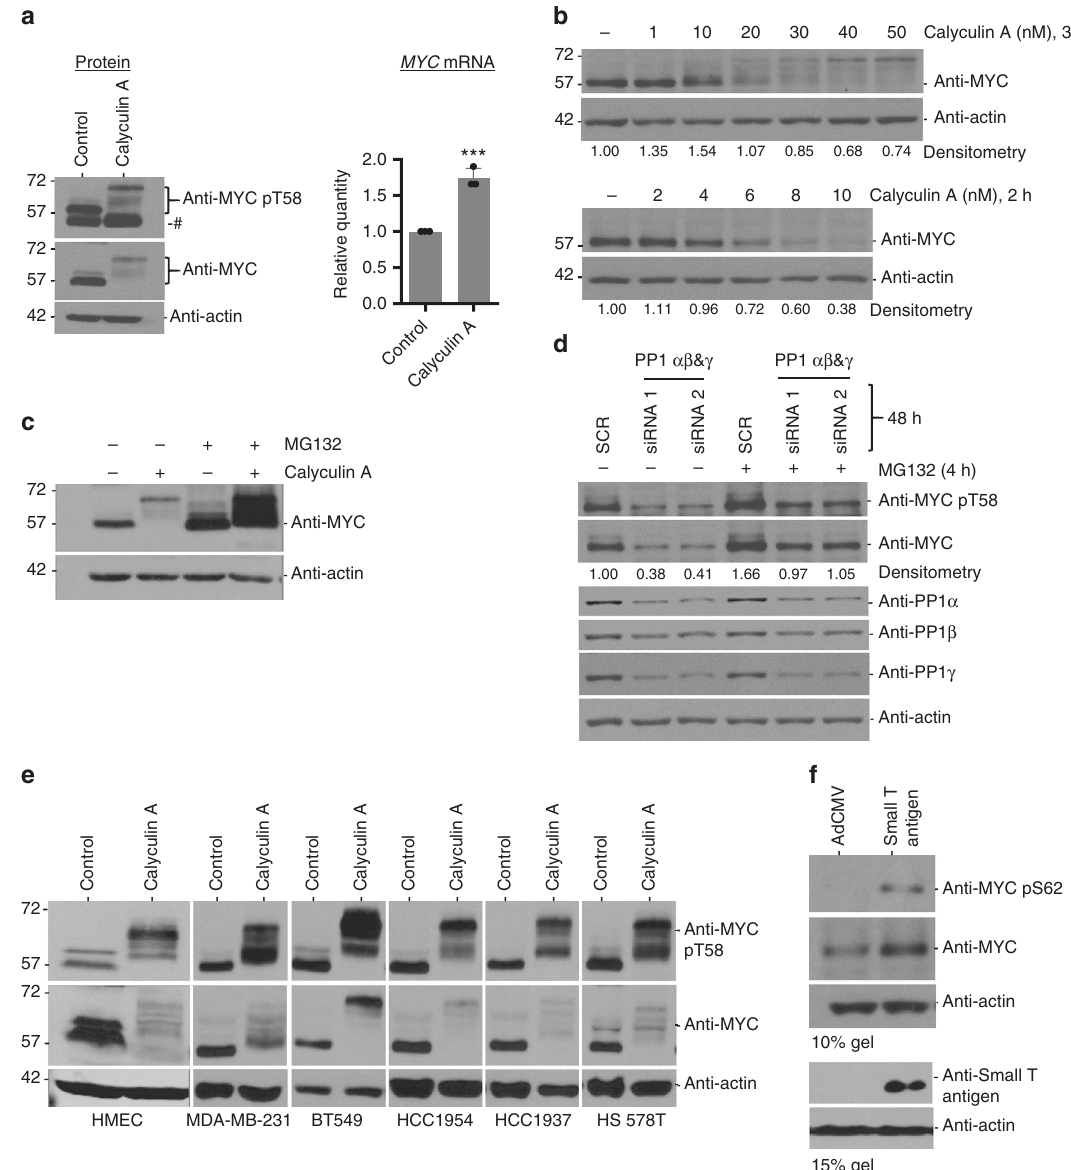
Fig. 3 Inhibition of PP1 results in decreased MYC protein levels. a MCF10A cells treated with Calyculin A (50 nM) for 30 min and lysed for protein or RNA extraction. Immunoblots of lysates were probed with MYC mouse, MYC pT58 rabbit, or actin rabbit antibody (left panel). # indicates non-speci fi c band. cDNA was made from extracted RNA and qRT-PCR was performed with primers against MYC or RPLP0 as an internal control. Data are from three biological replicates, mean is shown. *** p < 0.001; unpaired t -test, error bars represent s.d. b MCF10A cells were treated with Calyculin A at 1, 10, 20, 30, 40, 50 nM for 30 min (top panel) or 2, 4, 6, 8, 10 nM for 2 h (bottom panel) and lysed. Immunoblots were probed with MYC mouse or actin rabbit antibody. c Growing MCF10A cells were treated with MG132 (10 µ M) for 4 h ± Calyculin A (50 nM) for 30 min and lysed. Immunoblots were probed with MYC mouse or actin rabbit antibody. d Growing MCF10A cells transfected with 10 nM siRNA directed against PP1 α , β , and γ or universal scramble negative control by calcium phosphate. After 44 h transfection, cells were treated with 10 µ M MG132 or vehicle control for 4 h and lysed. Immunoblots were probed with shown antibodies. e Growing HMEC, MDA-MB-231, BT549, HCC1954, HCC1937, or HS578T cells were treated with Calyculin A (50 nM) for 30 min and lysed. Immunoblots of lysates were probed with shown antibodies. f MCF10A cells expressing ectopic MYC were seeded, grown overnight, serum starved for 24 h, and then infected with 200 MOI of empty vector adenovirus (AdCMV) or adenovirus carrying small T antigen. Cells were grown for 22 h in 0.25% serum media, lysed, and lysates immunoblotted with indicated antibodies. Shown are representative images of n =